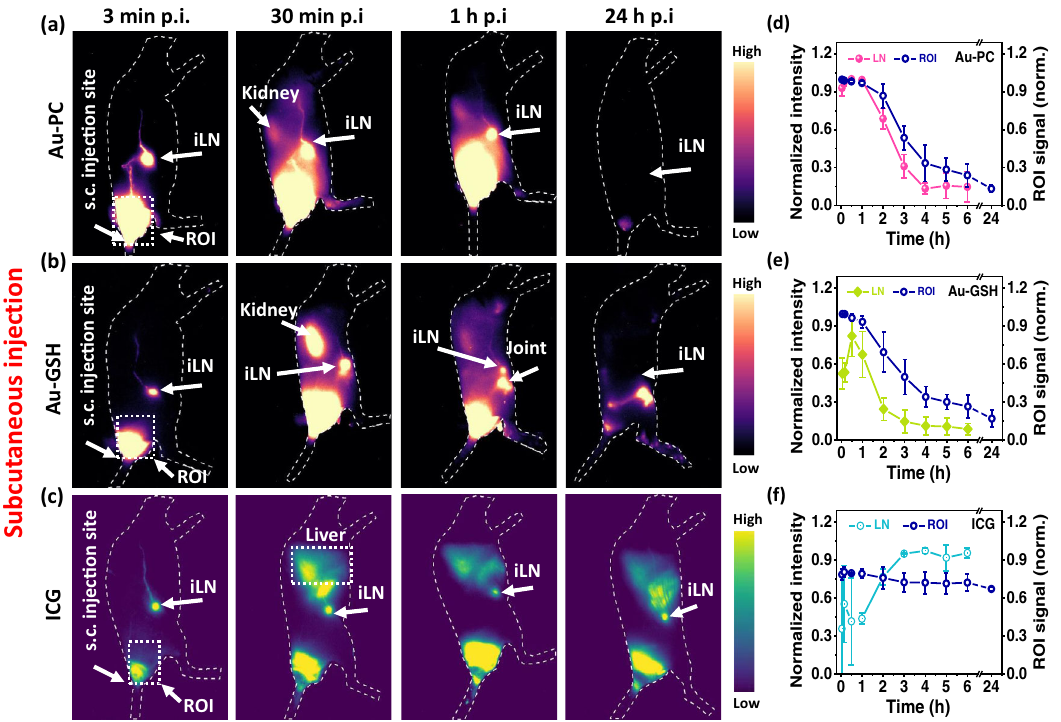
Fig.5|Invivo fl uorescenceimagingwithsubcutaneousinjectedAu-PC,Au-GSH and ICG. Wide- fi eld NIR-II fl uorescence images (excited by an 808nm laser at a power density of 70mW/cm 2 , exposure times 100ms and 4ms for Au and ICG, respectively, 1100nm long pass fi lter) of bilateral subcutaneously (s.c.) injected a Au-PC conjugate (4x, ~ 1.2mg), b Au-GSH cluster (4x, ~ 1.2mg) and c ICG (50 µ L, 50mM)probesatdifferenttimepoints(sixtosevenweeksoldfemaleBalb/c, n =3).